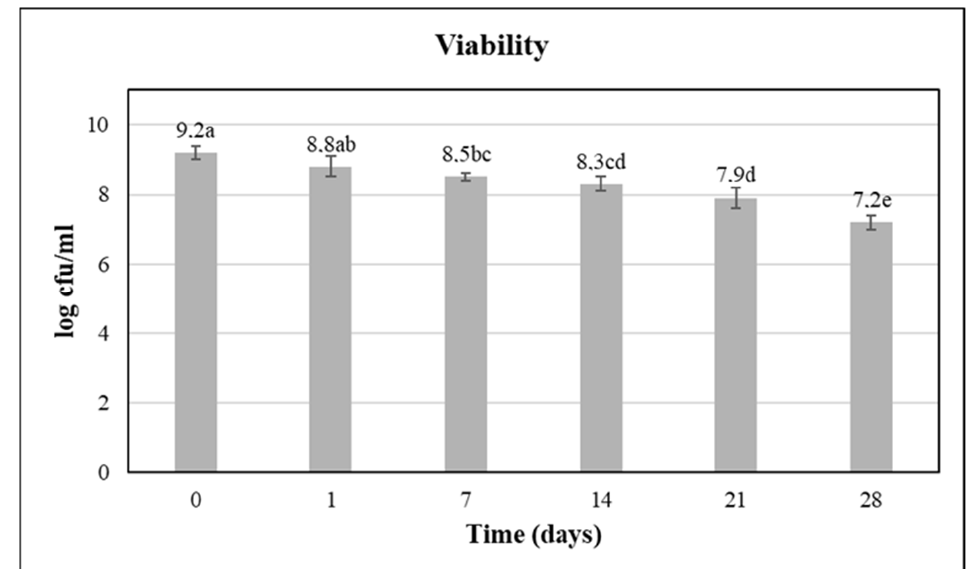
Figure 1. Viability of L. paracasei SP3 (log CFU/mL) after production (D 0 ) and during cold storage (4 °C), similar superscript letters in bars denote no significant differences at an alpha = 0.05 (ANOVA and Duncan Post Hoc Multiple Comparisons).